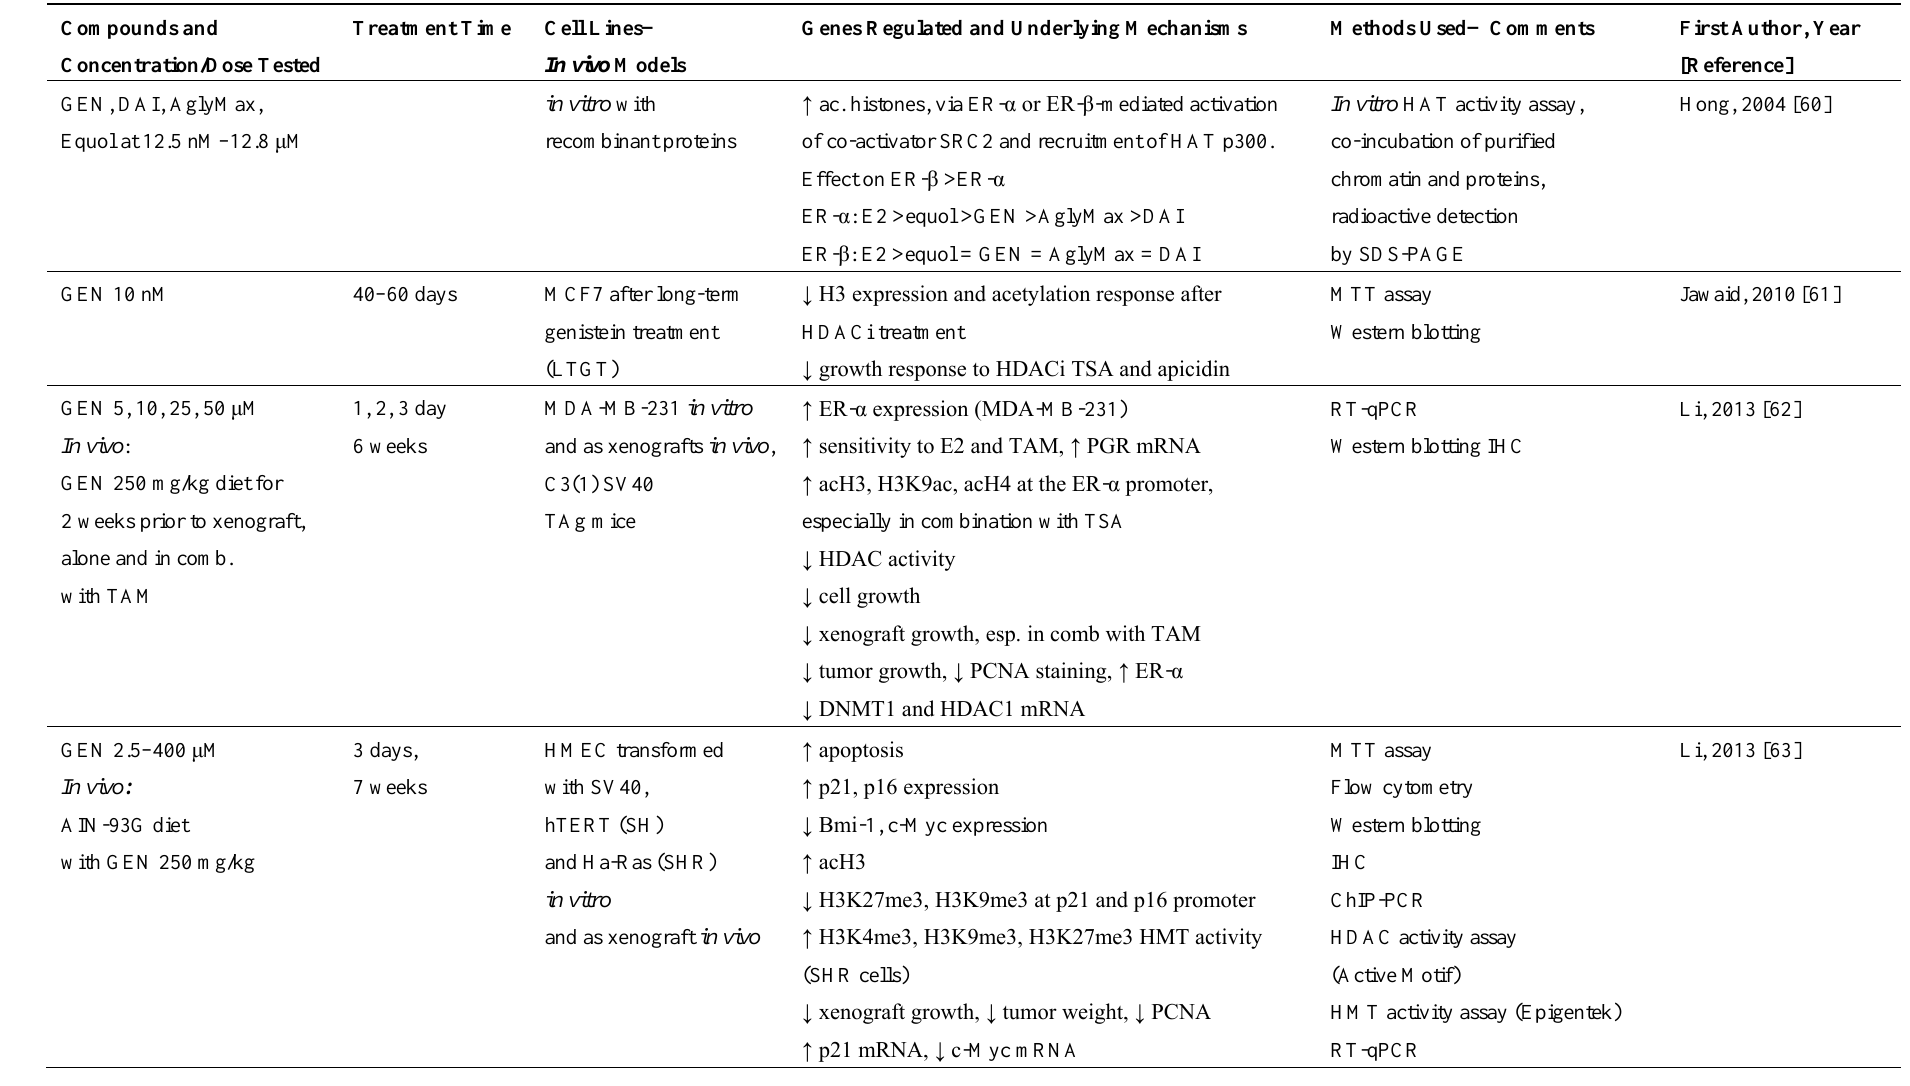
Table 1. Soy isoflavones targeting epigenetic mechanisms in breast (cancer) in vitro and in